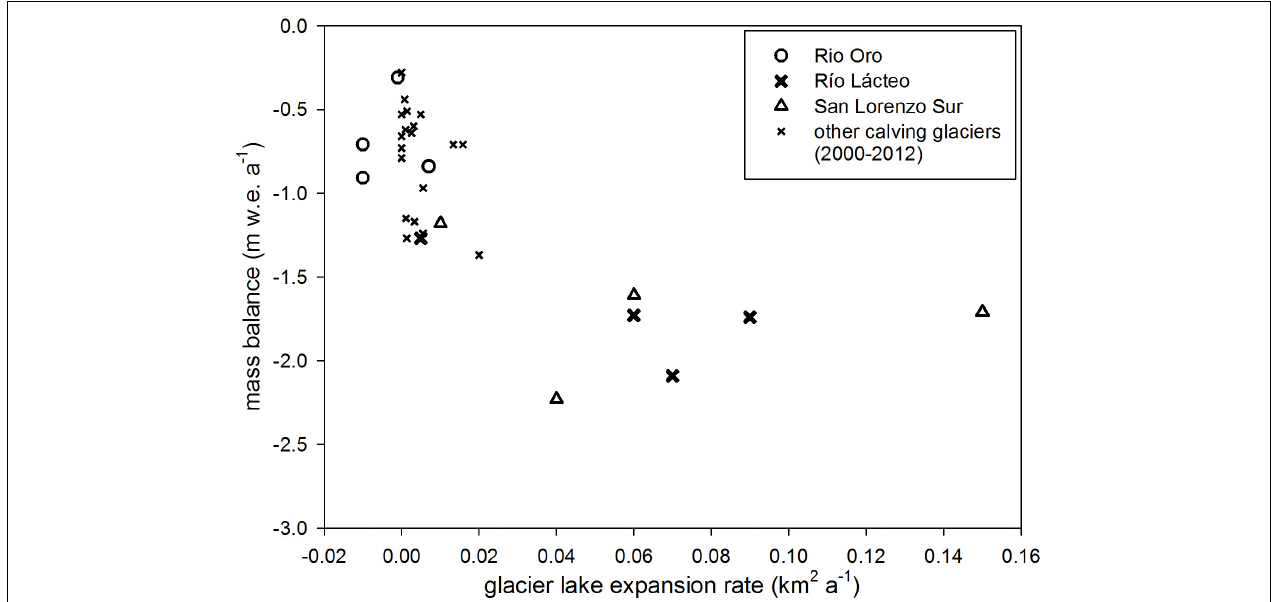
FIGURE 9 | Scatter plot showing the relation between glacier mass balance and proglacial lake expansion